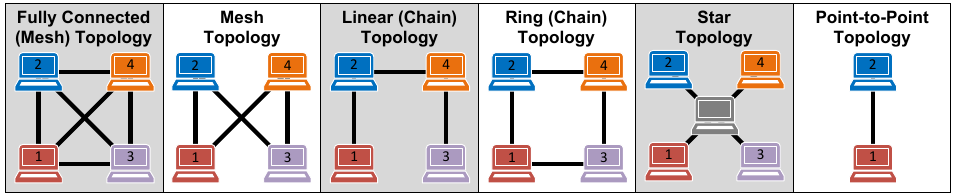
Figure 2. Examples of basic data communication